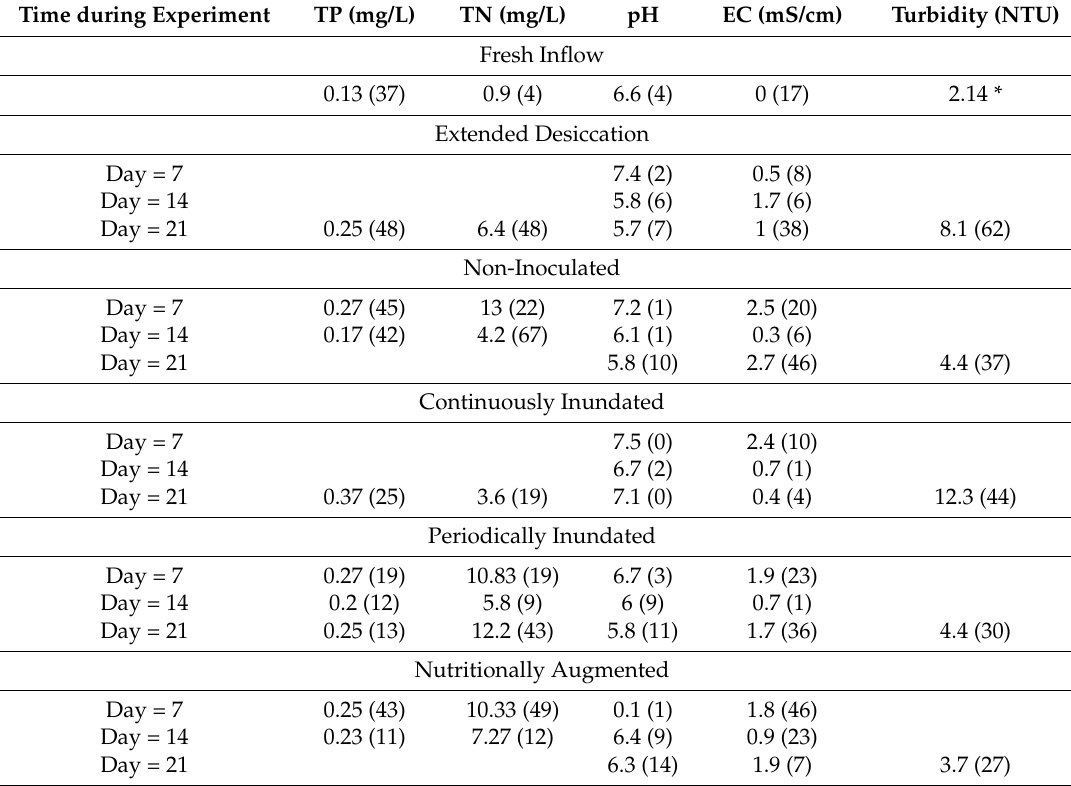
Table A2. Changes of nutrients in inundating water; means (and relative standard deviations in %) of TP and TN concentration of weekly inflow